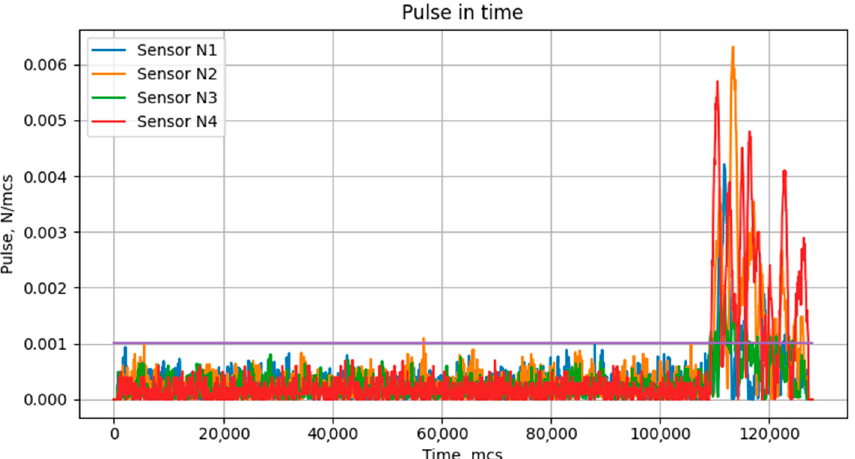
Figure 12. Increasing the signal value derivative for each of four strain gauge sensors.